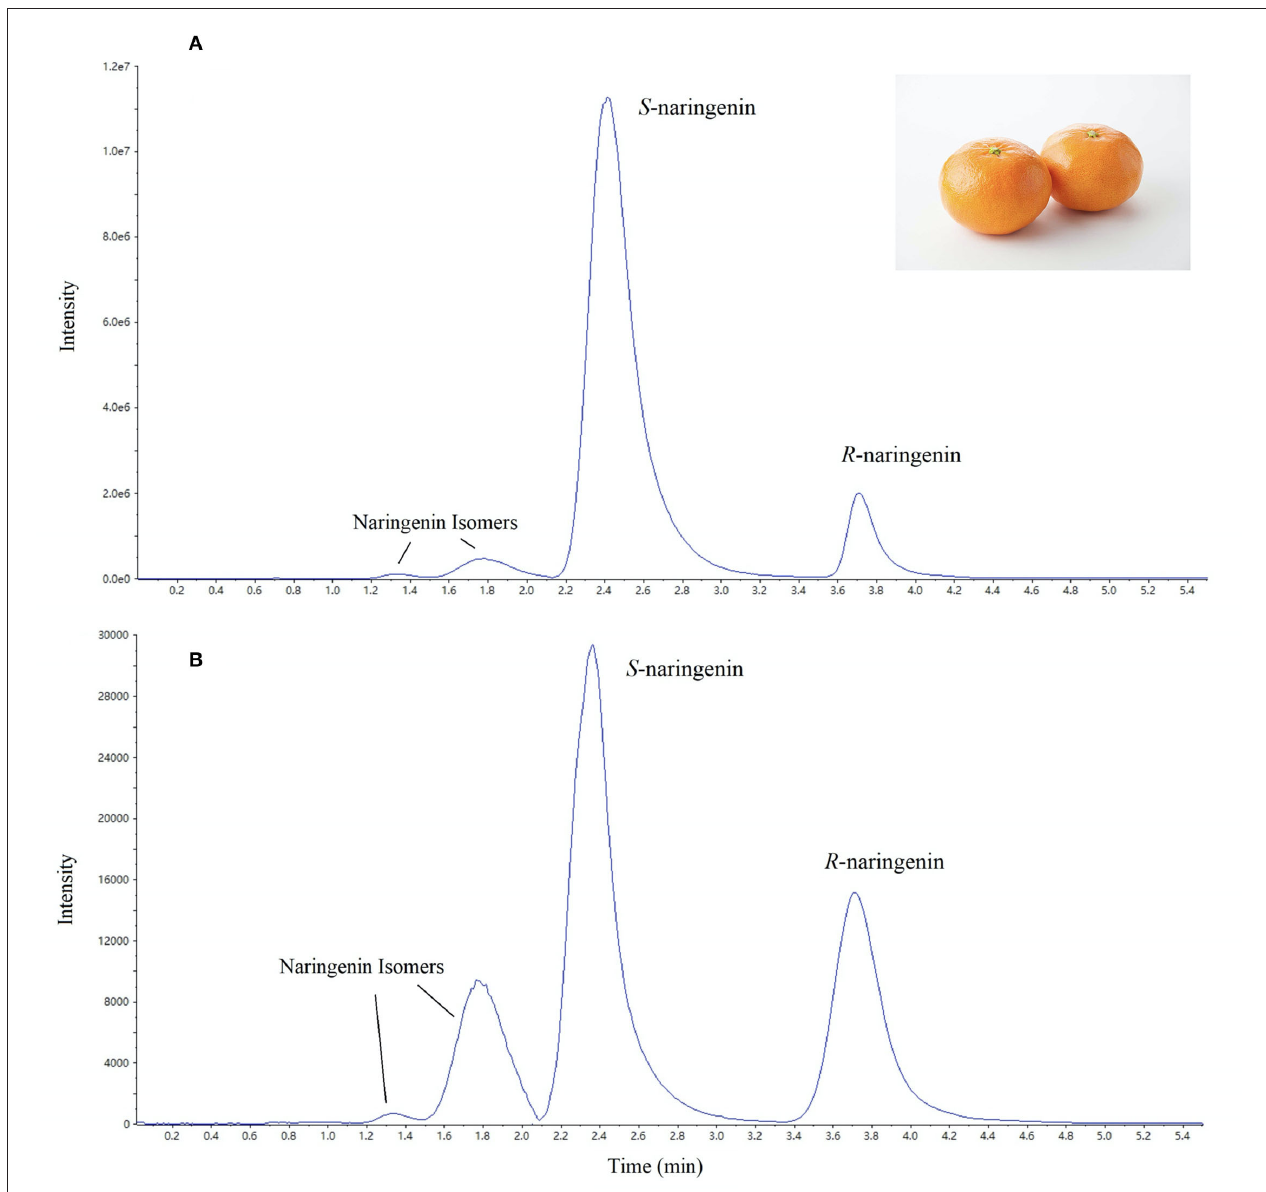
FIGURE 6 | Typical mass spectra of real citrus samples. (A) citrus peel and (B) citrus